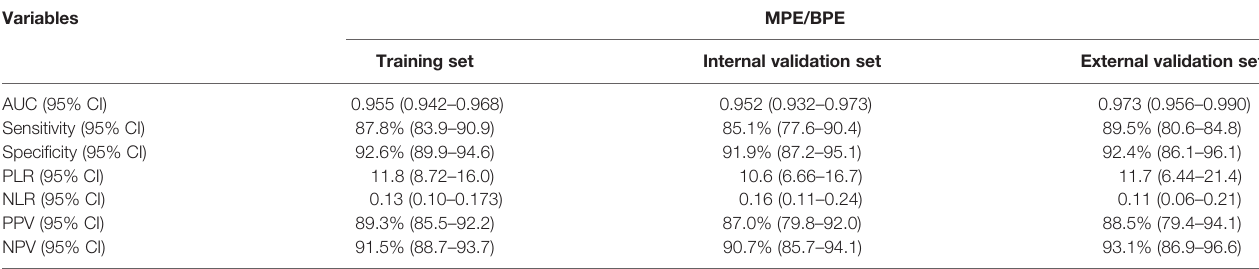
TABLE 4 | Accuracy of the prediction score of the nomogram for differentiating MPE from BPE.